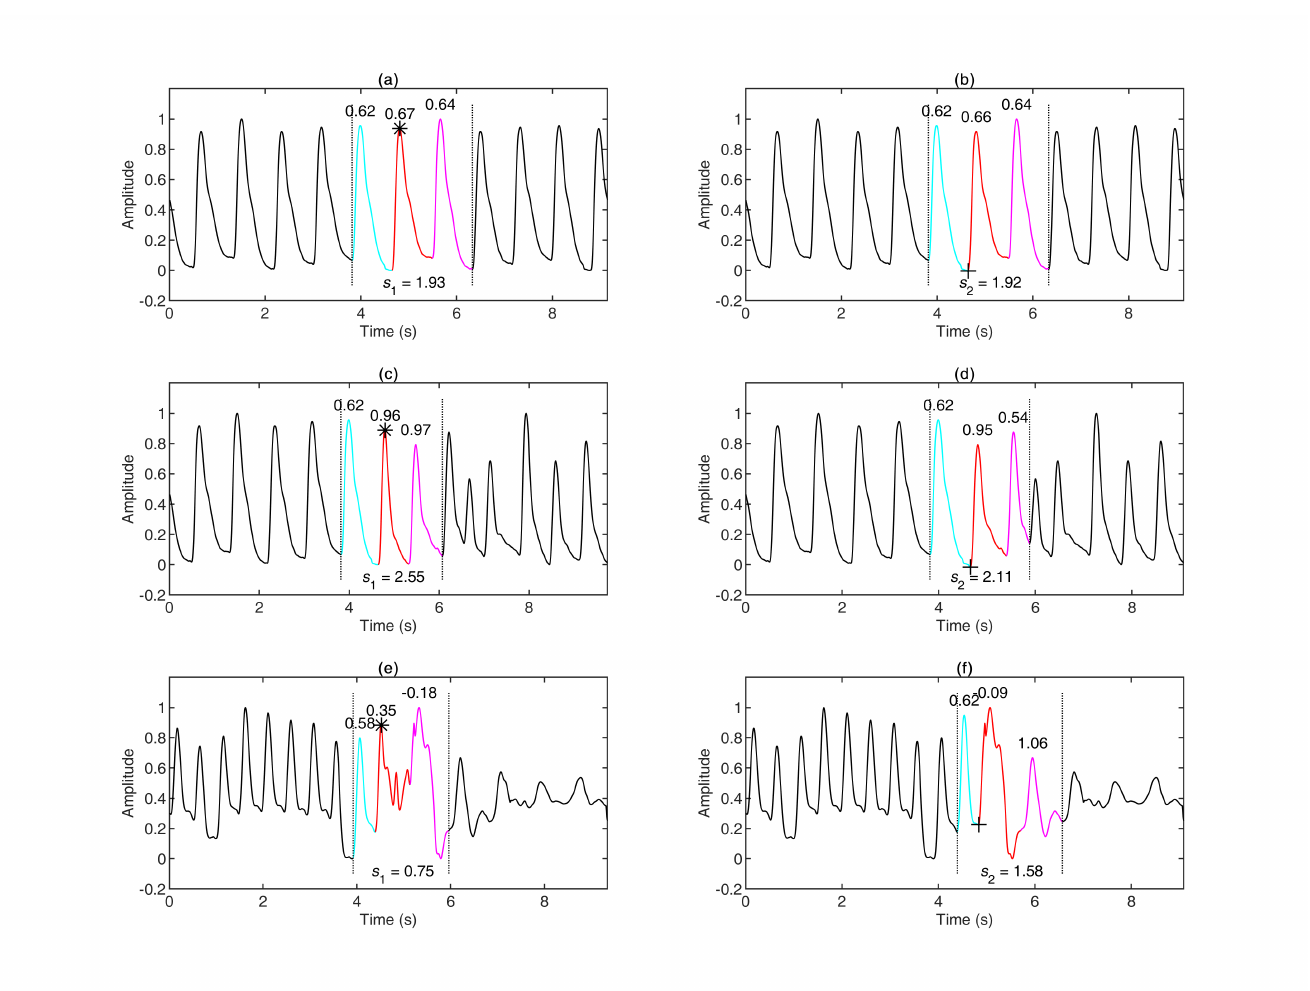
Figure 4. Three examples of stitching results. ( a , b ) are the results of stitching two regular PPGs together based on the systolic peak and the onset, respectively. ( c , d ) are the results of stitching a regular PPG with an irregular PPG based on the systolic peak and the onset, respectively. ( e , f ) are the results of stitching a noisy PPG with an irregular PPG based on the systolic peak and the onset, respectively. The stitching points are denoted as “*” in ( a , c , e ) and as “+” in ( b , d , f ). The cyan, red, and magenta parts are the previous, stitching, and next beats, respectively. The numbers above the curve represent the skewness of the beat. The “ s 1 ” and “ s 2 ” refer to the skewness index in the stitching methods based on the systolic peak and the onset,